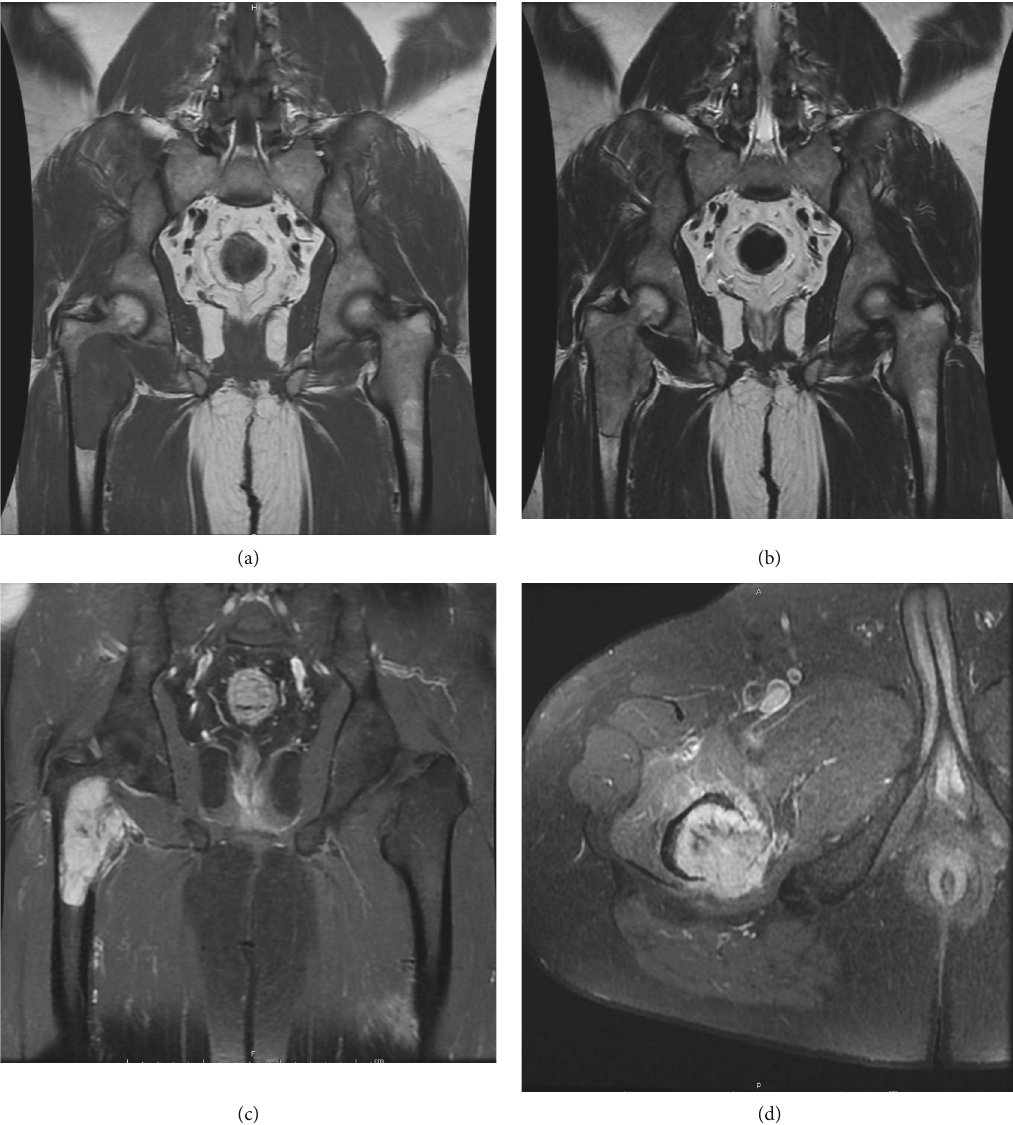
Figure 3: The MRI revealed the tumor at right proximal femur with soft tissue extension, especially at posteromedial aspect: MRI coronal T1 weight (a), coronal T2 weight (b), coronal T1 + contrast (c), and axial T1 + contrast